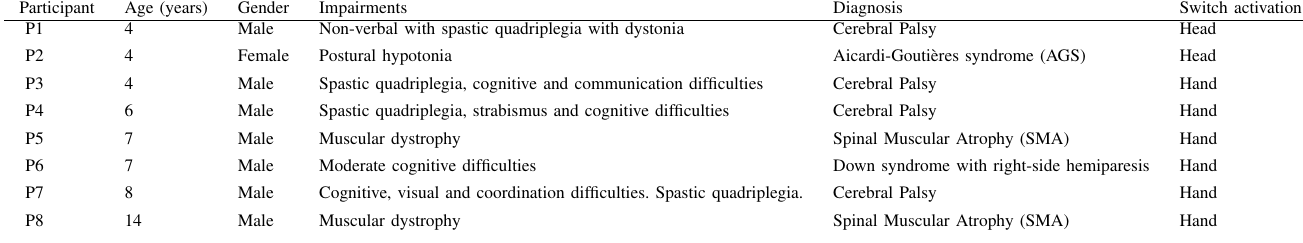
TABLE II. P ARTICIPANTS WITH DETAILS ABOUT AGE , IMPAIRMENTS , DIAGNOSIS AND BODY PART USED FOR OPERATING THE SWITCH